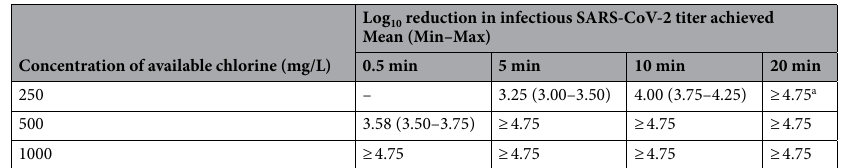
Table 3. Inactivation effects of chlorinated disinfectants on SARS-CoV-2. a The value of ≥ 4.75 means that no live virus is observed after the treatment, while the smaller values mean that a different amount of virus survives after the treatment. Results shown are the average of at least three replicate experiments.